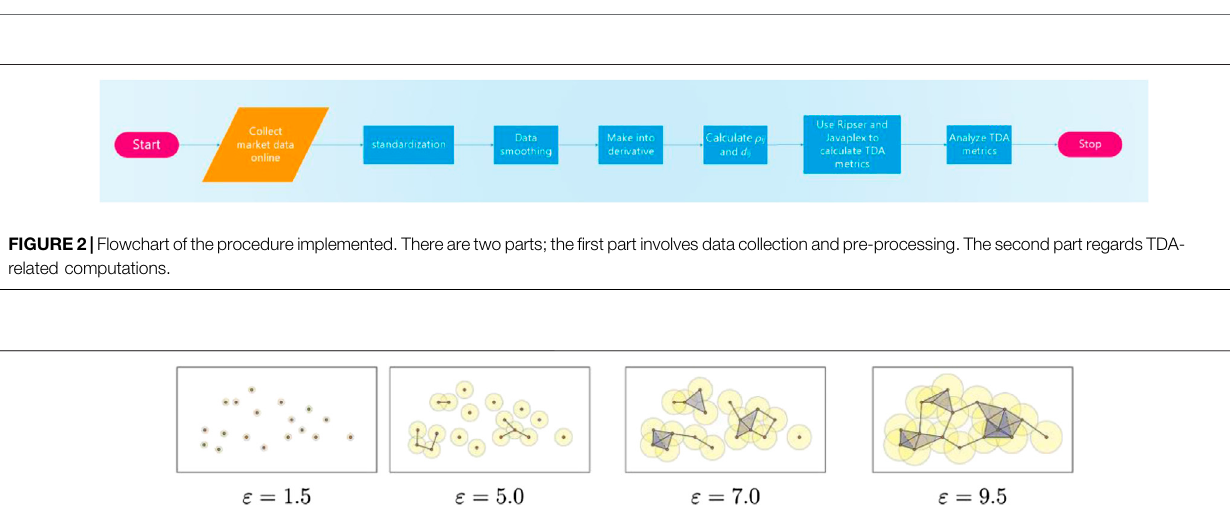
FIGURE 3 | A schematic diagram showing a data cloud, and how the fi ltration process results in outcomes of various overlapping of balls from different proximity parameters ϵ (shown in the upper column). The bottom column is barcodes scanning through a full-range of proximity parameter ϵ values. β 0 and β 1 denote the 0-dim and 1-dim Betti numbers, which can be deduced from the sub fi gures to be roughly 18 → 11 → 4 → 1, and 0 → 0 → 1 → 2, respectively.